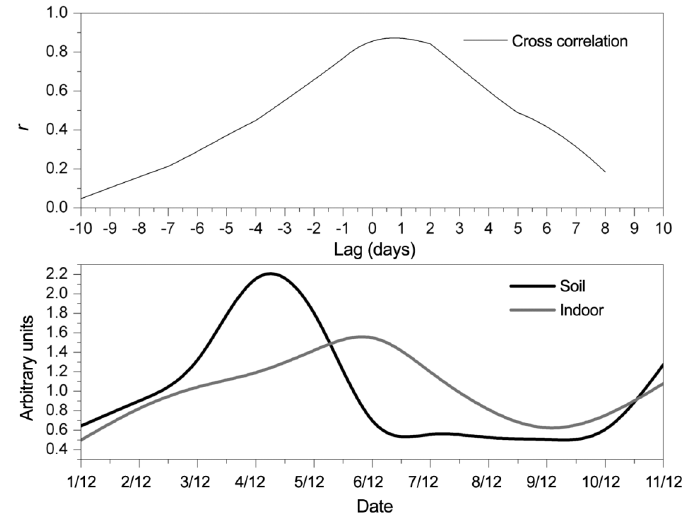
Fig. 5. Cross-correlation (upper plot) between soil and indoor radon trend (down plot) site of Modica .